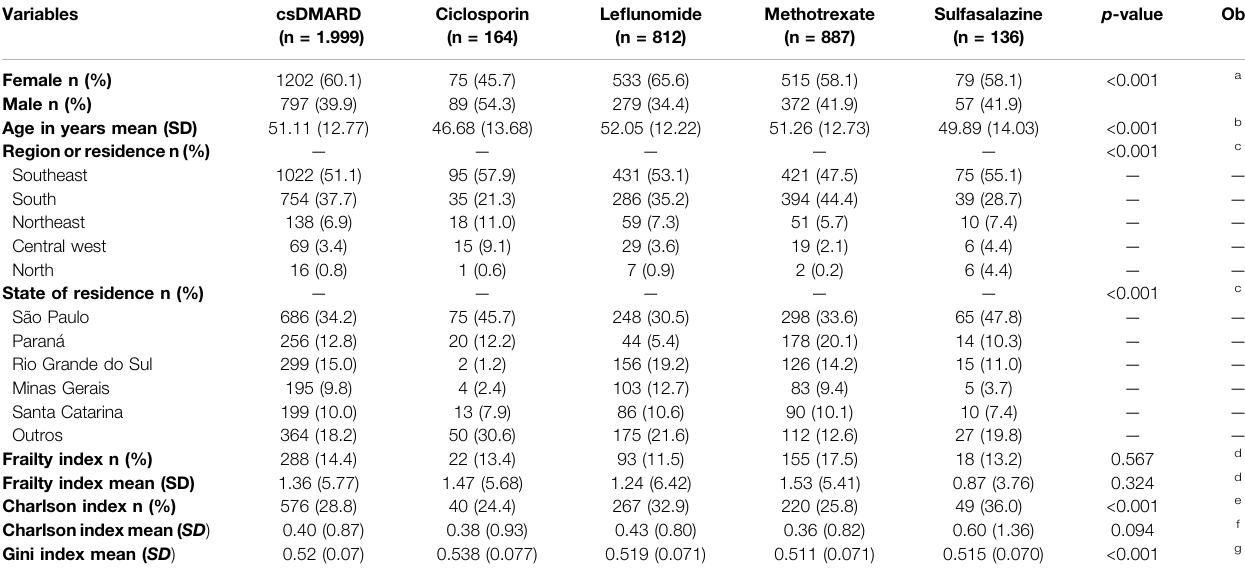
TABLE 1 | Baseline characteristics of PsA patients who used csDMARD.